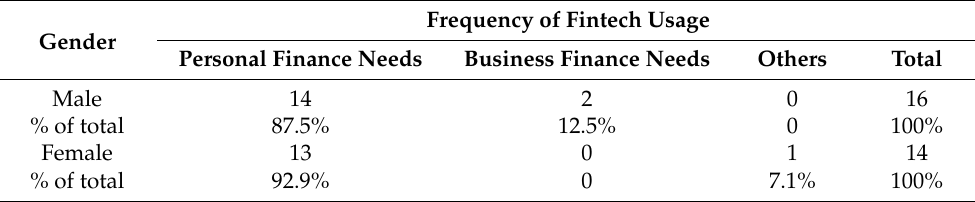
Table 8. Respondents’ gender and Fintech usage purpose.